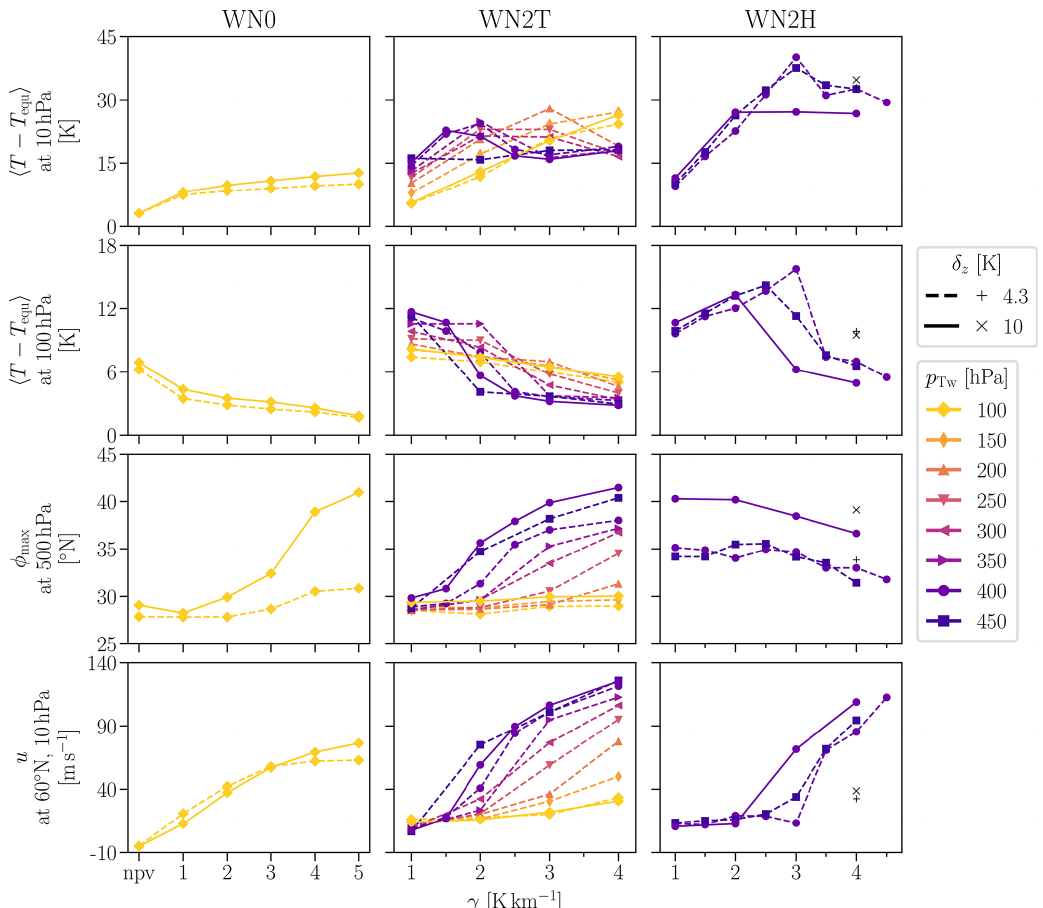
Figure 8. Top row: difference between temperature and equilibrium temperature T − T eq averaged from 40 to 90 ◦ N at 10hPa. Second row: same but at 100hPa. Third row: latitude φ max of the zonal-mean zonal wind speed maximum of the tropospheric jet. Fourth row: zonal-mean zonal wind u at 60 ◦ N and 10hPa. The left column shows results from model simulations without planetary wave forcing, the middle column with WN2 topography of height h = 3km and the right column with WN2 tropospheric heating of amplitude q 0 = 6Kd − 1 . Solid lines represent simulations with standard δ z = 10K, dashed lines with reduced δ z = 4 .